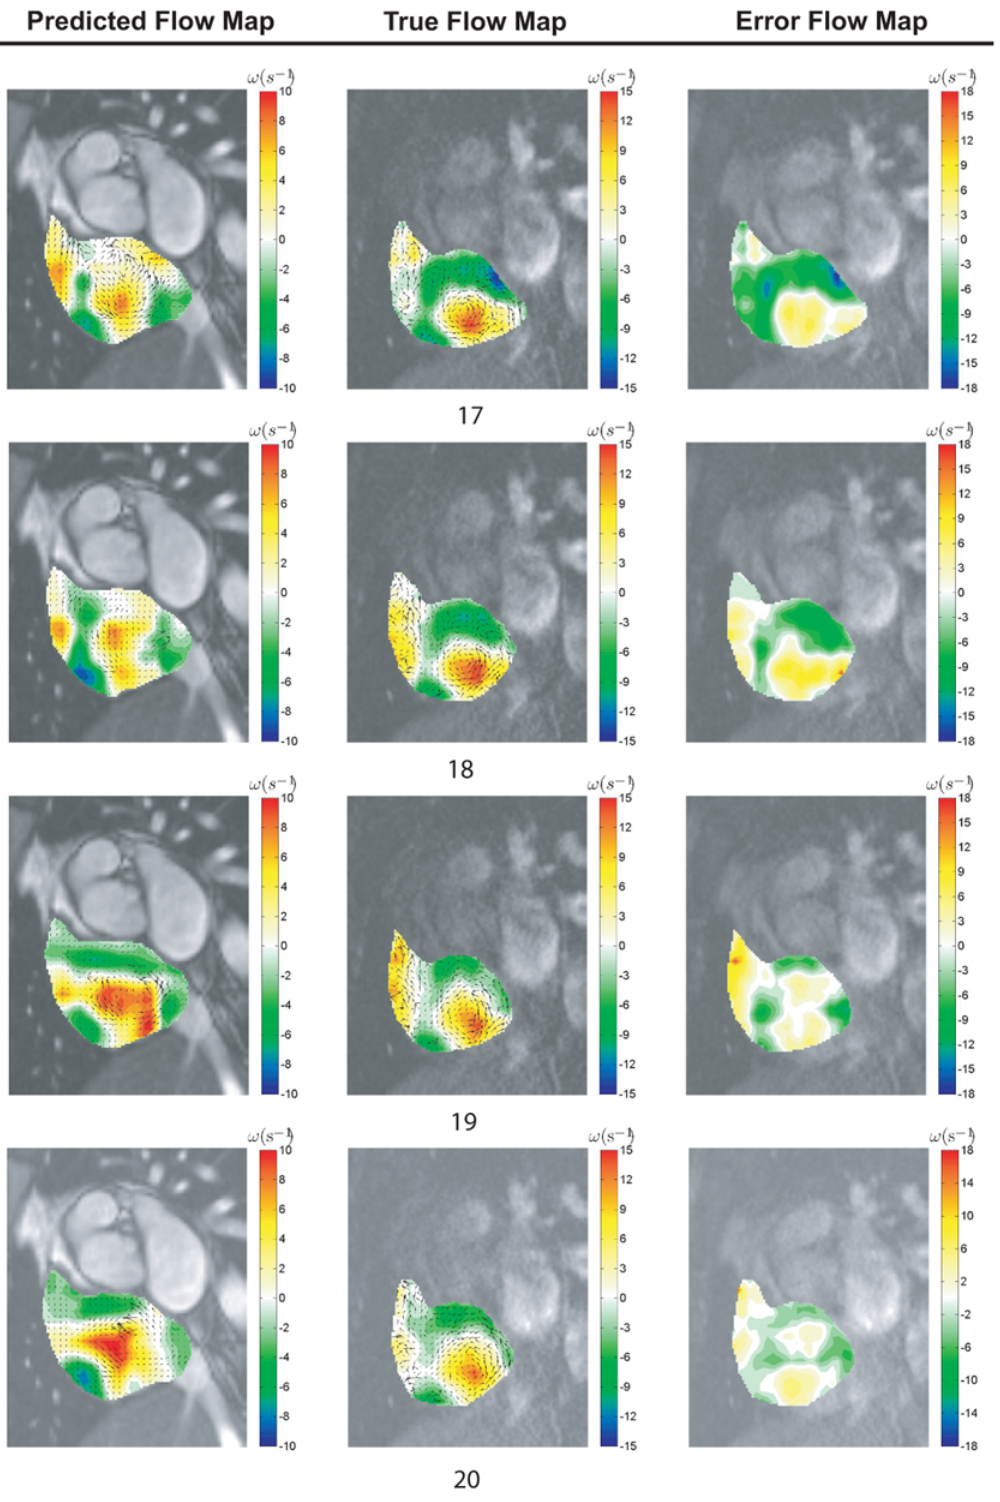
Figure 13. Vorticity differencing based on MR fluid motion and phase contrast magnetic resonance image fields. Predicted flow fields generated by MR fluid motion tracking are verified against the measured ones based on phase contrast magnetic resonance image velocimetry. The former technique post-processes temporal MR signals to compute flow, while the latter velocimetry system processes the signal during scan and encodes the velocity information in images. The set of results presented here illustrates the difference between blood flow fields in the human right atrium, of which one is predicted and the other is accurately measured. Therefore, their vorticity map differences can be taken as the deviation of MR fluid motion field from the true flow field. We demonstrate flow field differencing using time frames, n t =[17, 18, 19, 20] out of 25 frames in a cardiac cycle. doi:10.1371/journal.pone.0005688.g013 PLoS ONE |